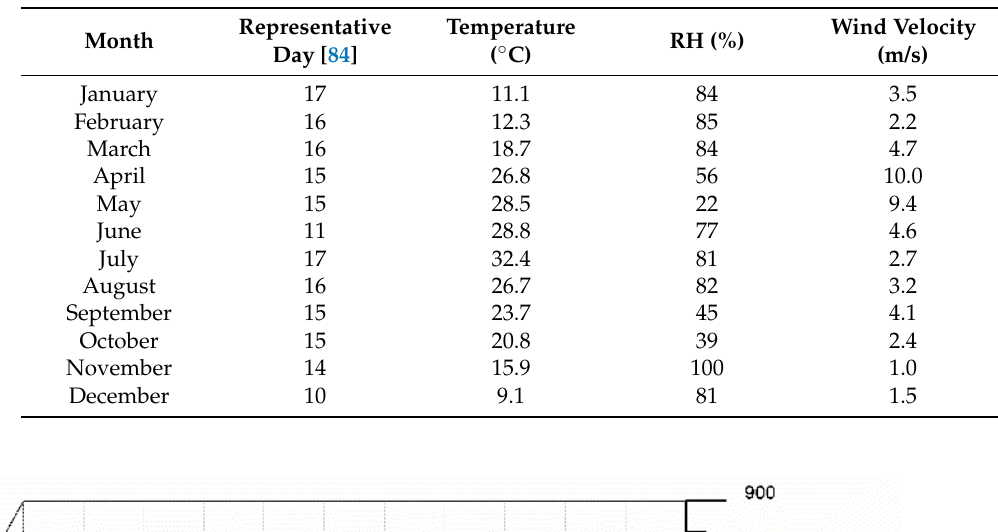
Table 2. Parameters for the calculation of water productivity.